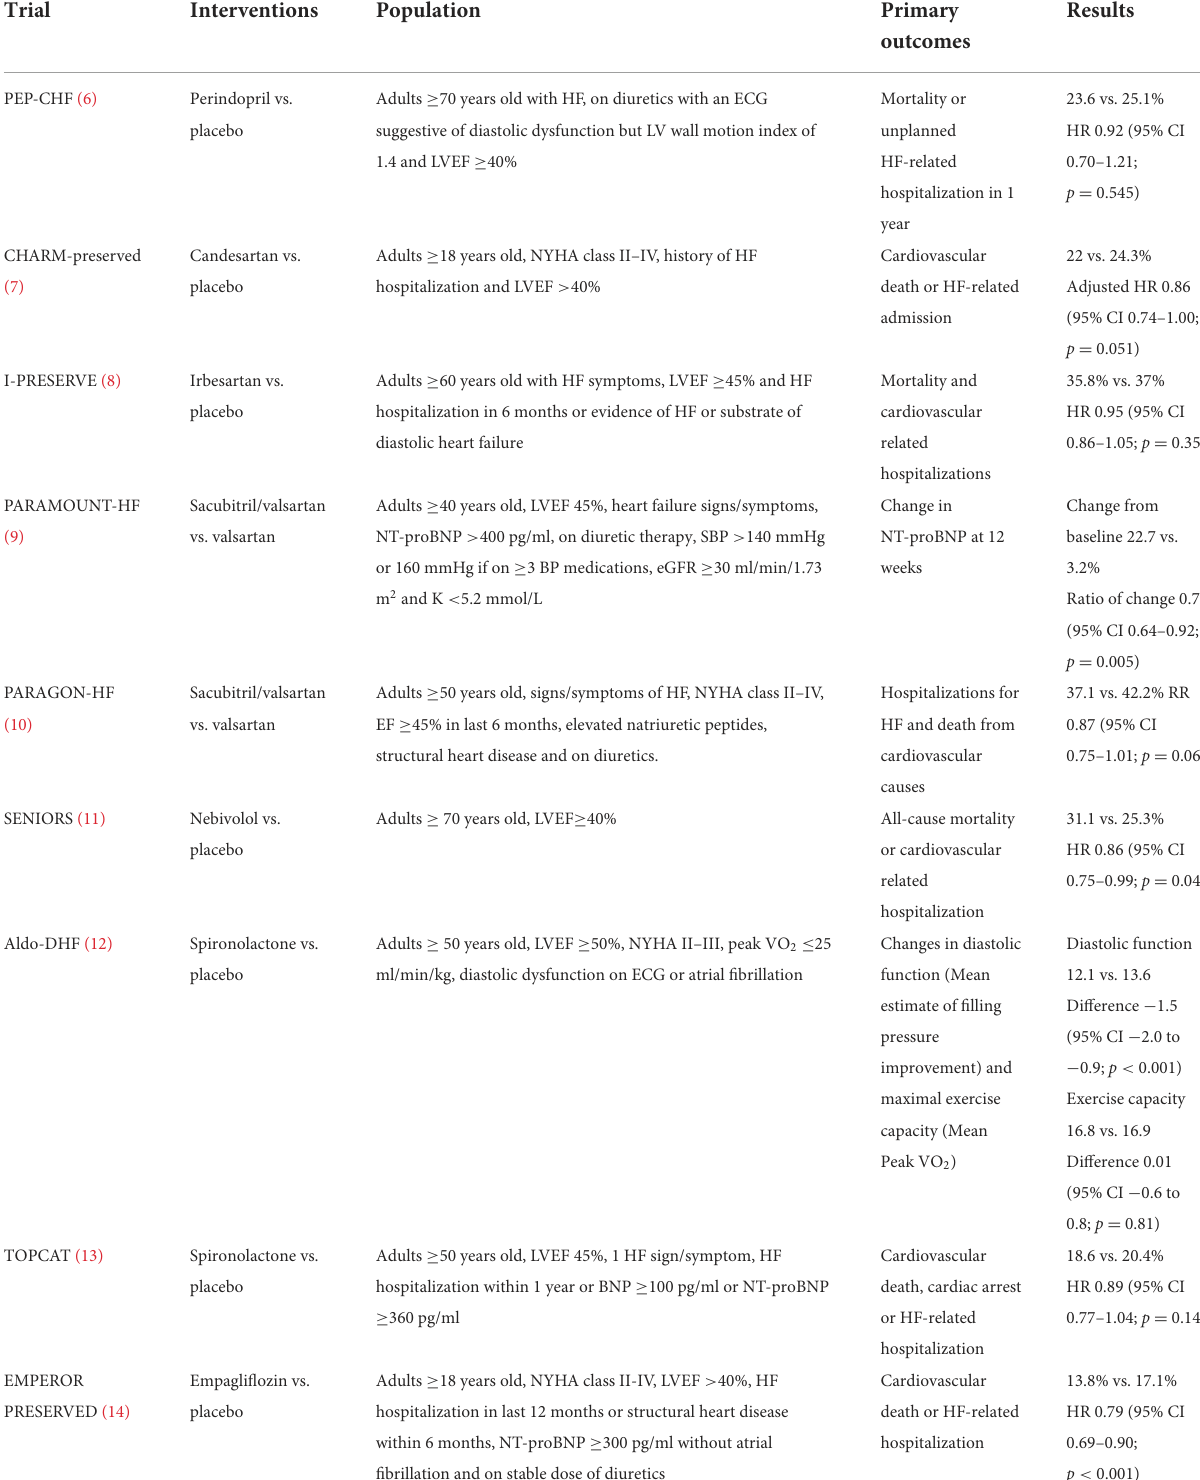
TABLE 1 Summary of select clinical